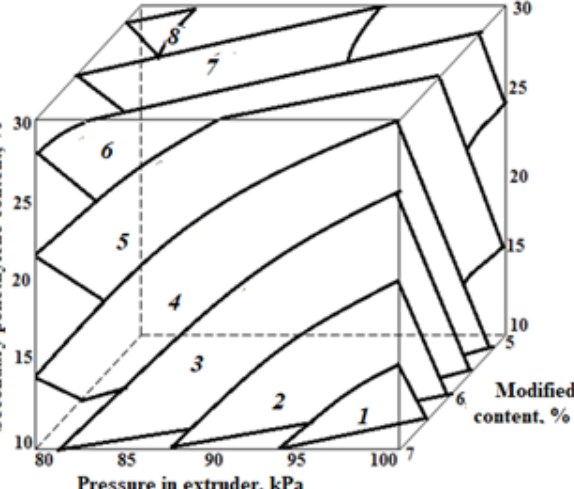
Figure 2. Dependence of the average density of polyethylene foam (Y1, kg/m 3 ) on the consumption of recycled polyethylene, modifier, and air pressure in the extruder at the optimum flame retardant consumption of 11.7 kg/m 3 . Average density values, kg/m 3 : 1 – 20; 2 – 22; 3 – 24; 4 – 26; 5 – 28; 6 – 30; 7 – 32; 8 – 34.